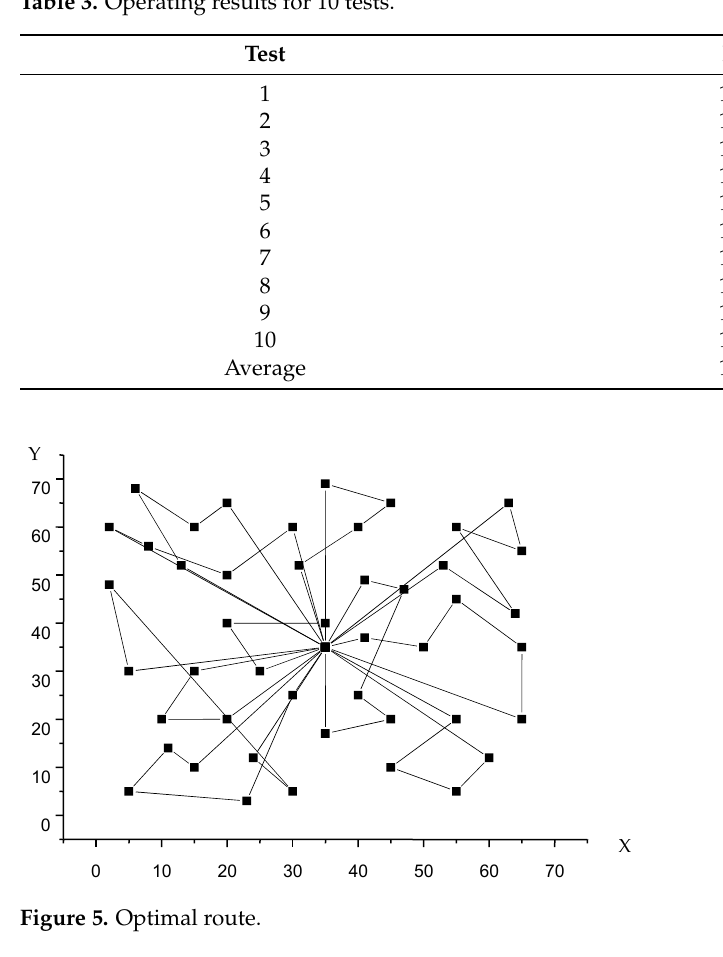
Table 3. Operating results for 10 tests.